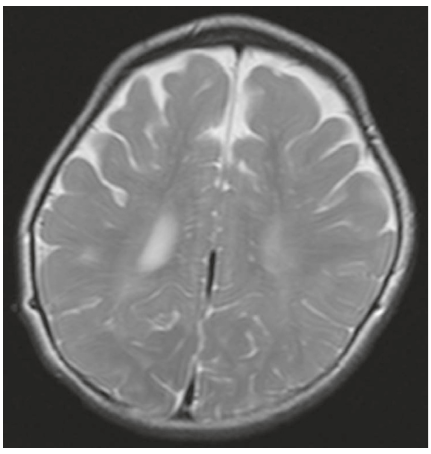
Figure 9: Head magnetic resonance image revealing an enlarged Virchow-Robin